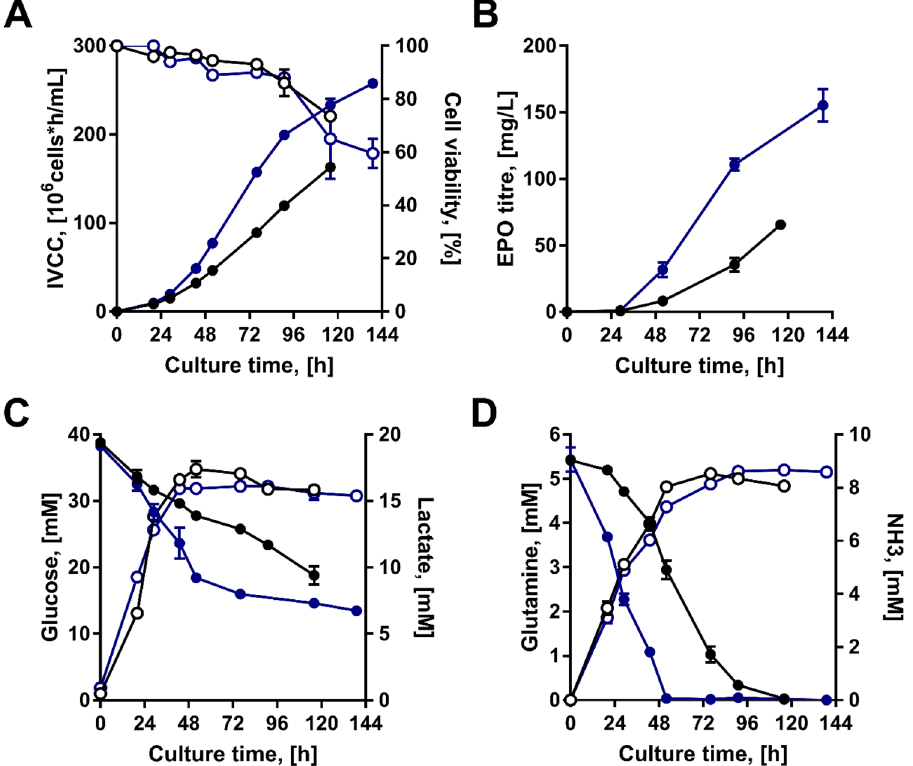
Figure 5. Comparison of the CHO EPO and CHOCX EPO cell lines in controlled bioreactors with 40 mM glucose and at 37C. ( black ) CHO EPO , ( blue ) CHOCX EPO . ( A ) Integral of viable cell concentration (IVCC, filled circle) and cell viability percentage (light circle). ( B ) EPO titres. ( C ) Glucose (filled circle) and lactate profiles (light circle). ( D ) Glutamine (filled circle) and ammonia profiles (light circle). Experimental values represent the mean of two biological replicates ±